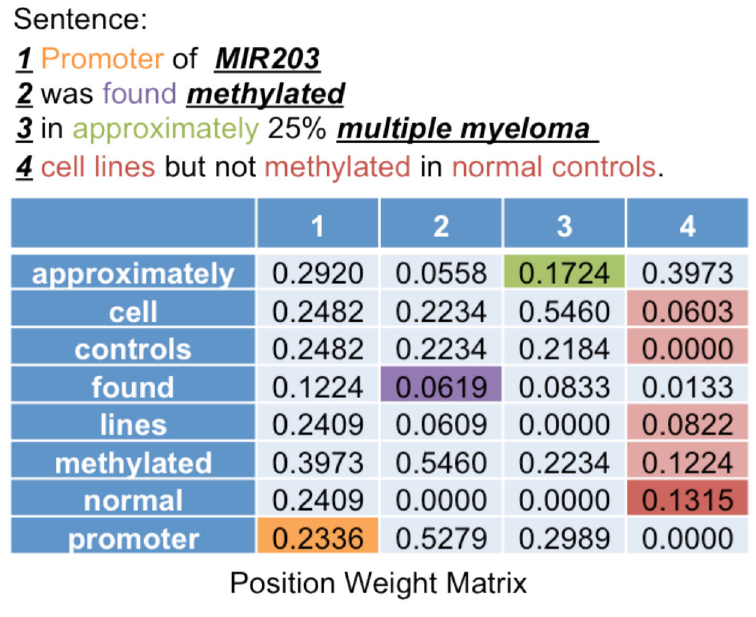
Figure 4. Computing the scores. The figure shows an example of a normalized PWM. To compute the score, we sum the weights of one word from each column. For example, the word ‘promoter’ appears in the first segment, so we take its weight from the first column in the PWM. The same step is applied to the second, and the third segments. However, five words appear in the last segment, so we take maximum weight. The score of the pattern is 0.2336+0.1619+0.1724+0.1315=0.5994. doi: